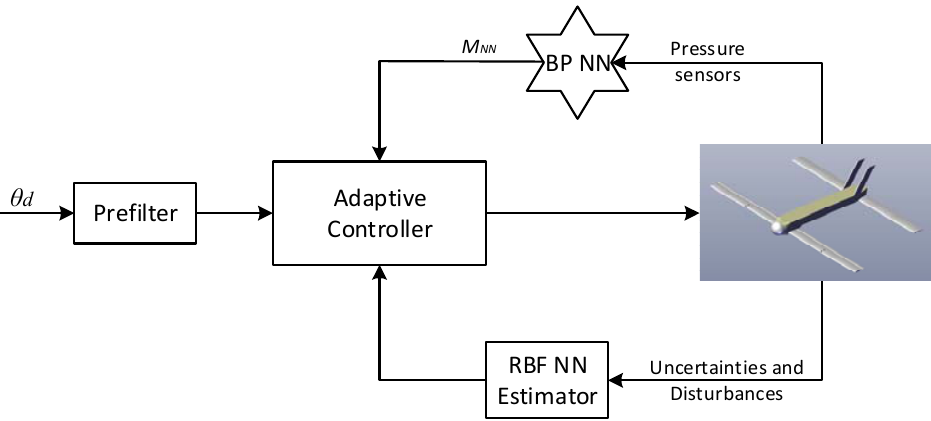
Figure 7. Block diagram of the bio-inspired control system. RBF: radial basis function.